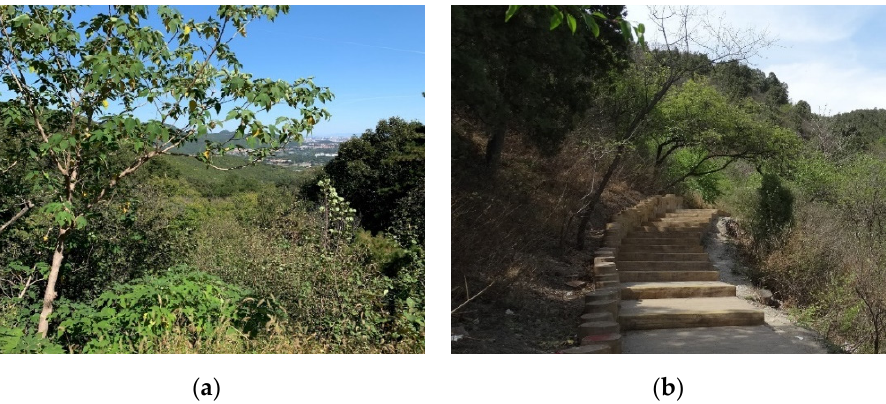
Figure 4. Forest landscape and artificial facilities in Xishan National Forest Park (XS): ( a ) Forest landscape; ( b ) Artificial facilities.